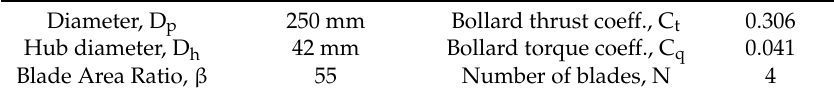
Table 2. Properties of the model propeller.